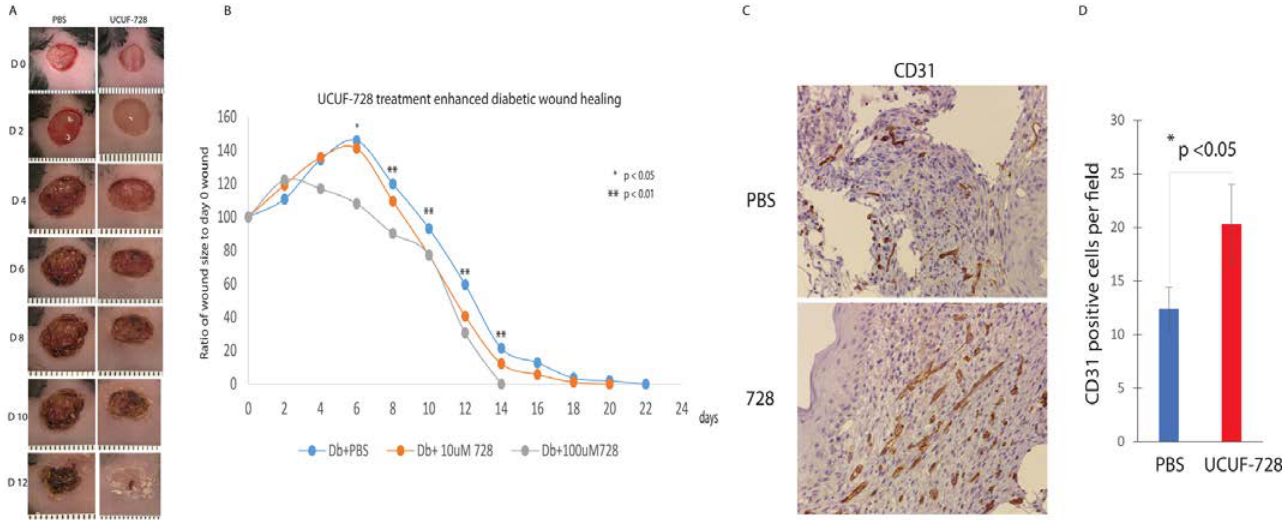
Figure 4. UCUF-728 enhances diabetic wound healing. ( A ) Representative photographs (days 0 to 12 post-wounding) of diabetic murine wounds treated with 0 (PBS), or 100 uM of UCUF-728 at the time of wounding. ( B ) Wound size change during the healing process of initial 8 mm wounds in Db mice treated by dermal injection of 10 uM UCUF-728 or PBS, n = 5 per group. ( C ) CD31+ staining of representative sections of diabetic wounds after 7 days of treatment with treated with PBS ( n = 5) or 100 uM UCUF-728 ( n = 5). ( D ) Quantitative analysis of number of vessels (CD31 staining) per 20× field. Comparison was performed between PBS and 100 uM UCUF-728 treated wounds. * p < 0.05; ** p < 0.01.